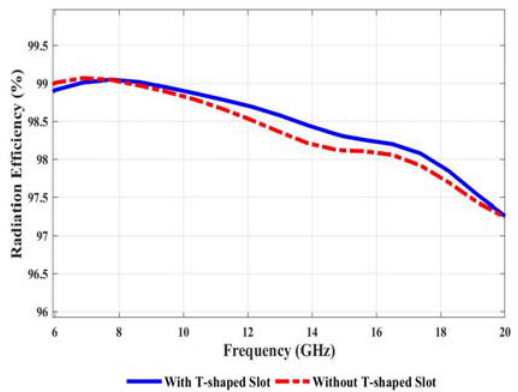
Fig. 5. Simulated radiation efficiency of the proposed flower-shaped antenna. The simulated peak realized gain of the proposed antenna versus frequency is depicted in Figure 6. In the working band, the gain varies from 2.6 to 3.95 dBi for a maximum gain found with 4.147 dBi at the frequency of 12.2 GHz in CST. Whereas in HFSS it goes till 5.25 dBi at the frequency 19.45 GHz, and which varies from 2.67 to 5.25 dBi. Besides, the minimum value of gain is obtained at 15.6 GHz with 2.45 dBi. Making an inverted cut of a T-shape on the ground plane proved its potential to improve antenna gain for frequencies between 10 and 15 GHz. Hence, since the proposed antenna is compact and planar, the gain obtained is at an acceptable level.